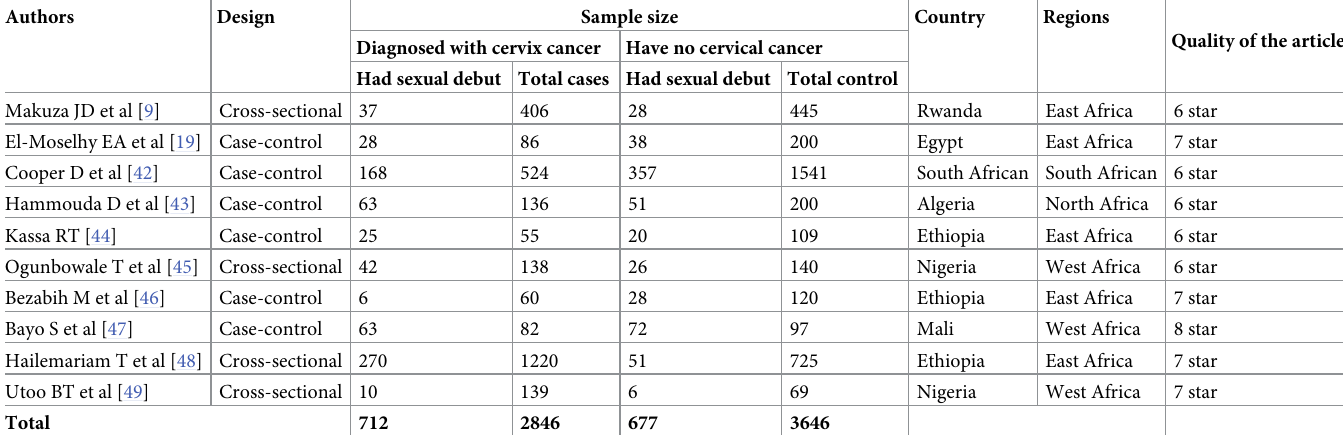
Table 1. Summary of the included studies, March